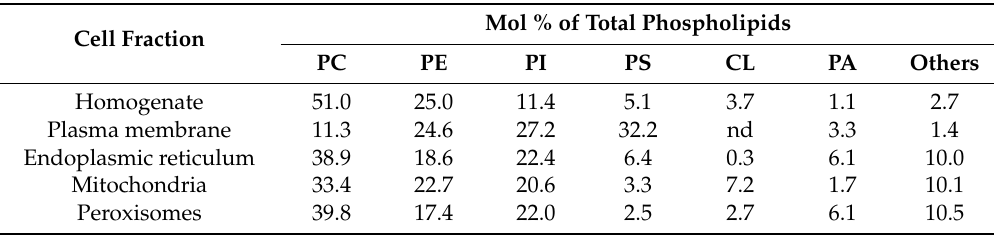
Table 1. Phospholipid composition in Saccharomyces cerevisiae